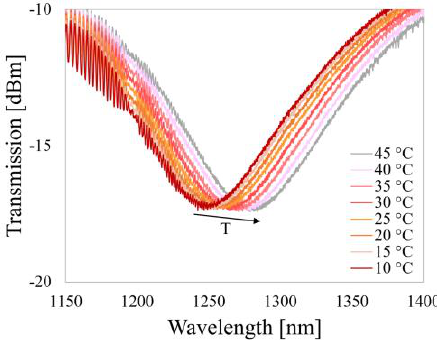
Figure 9. Transmission spectra of µIMZI at different temperatures (T) of water in the cavity.